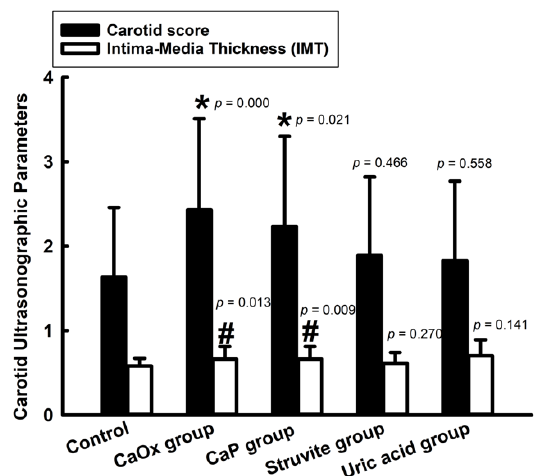
Figure 1. Carotid score and intima-media thickness (IMT) of carotid artery ultrasonographic scans in the different stone groups. *: p < 0.05 carotid score was significantly different when compared with the control. #: p < 0.05 IMT was significantly different when compared with the control. Abbreviation: CaOx, Calcium oxalate; CaP, Calcium phosphate.